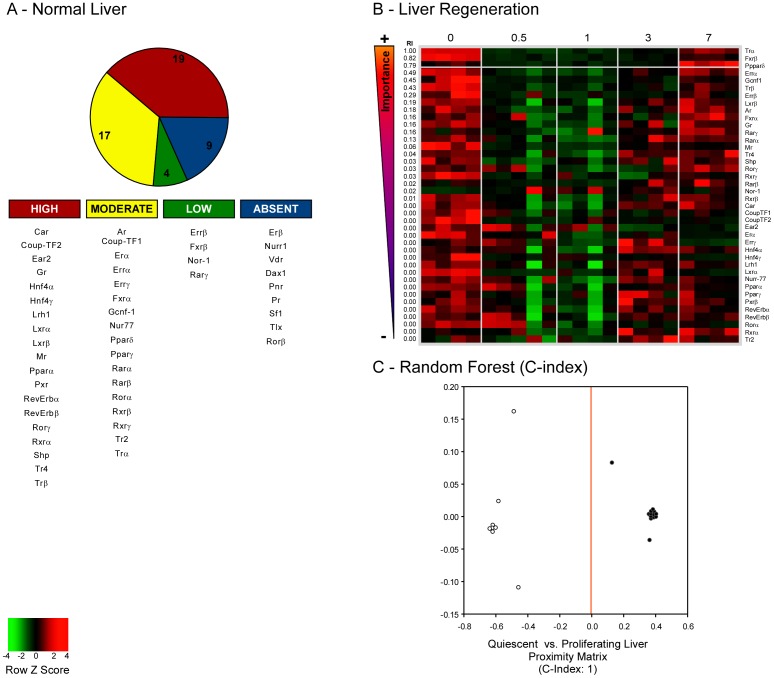
NRs mRNA expression levels in normal mouse liver (A) and after PH (B).Forty NRs were expressed in quiescent liver: 19 genes expressed at high level (red; Ct<25 or RU>1324), 17 NRs at moderate level (yellow; 25<Ct<30 or 8.9<RU<1324), 4 NRs at low level of expression (green; 30<Ct<35 or 0.1<RU<8.9), while 9 NRs were unexpressed (blue; Ct>35 or RU<0.1). Heatmap of the changes in NR transcriptome listed in order of RI at RF analysis, to identify candidate biomarkers of proliferation after PH. RF analysis highlights Trα, Fxrβ and Pparδ as classifiers of the “proliferative” status in LR experiments. Details of the changes observed for each NR are shown in Figure 2. (C) Proximity matrix of the RF algorithm. On the basis of the mRNA expression levels of Trα, Fxrβ and Ppparδ, RF discriminates a “quiescent” status (control liver and 7 days after PH) from a “proliferative” one (12 hours, 1 and 3 days after PH) in 100% of cases (C-Index = 1). Gapdh was used as reference gene, and values are expressed as relative units.